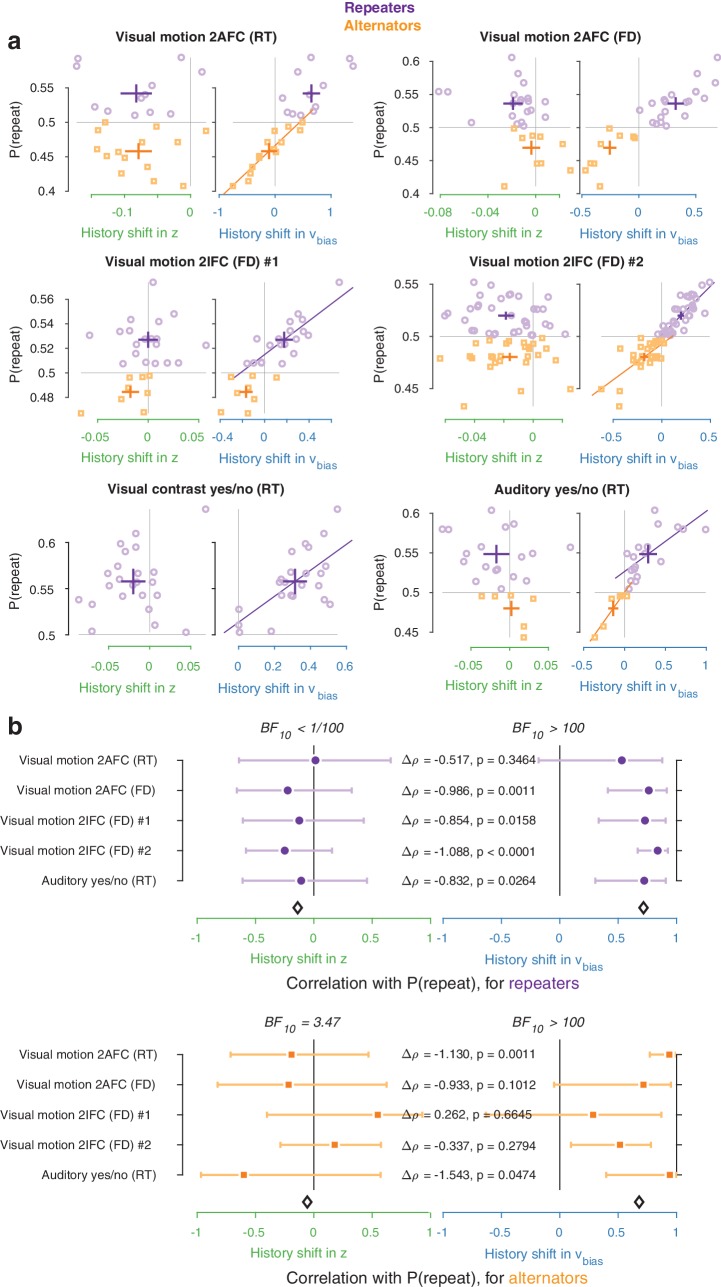
Same biasing mechanism under two pharmacological interventions.(a) Participants in the MEG study were assigned to one of three pharmacological groups. At the start of each experimental session, they orally took 40 mg atomoxetine (Strattera), 5 mg donepezil (Aricept), or placebo. Since the time of peak plasma concentration is 3 hr for donepezil (Rogers and Friedhoff, 1998) and 1–2 hr for atomoxetine (Sauer et al., 2005), we used a placebo-controlled, double-blind, double-dummy design, entailing an identical number of pills at the same times before every session for all participants. Participants in the donepezil group took 5 mg of donepezil 3 hr, and placebo 1.5 hr before starting the experimental session. Participants in the atomoxetine group took placebo 3 hr, and 40 mg of atomoxetine 1.5 hr before the experimental session. Those in the placebo group took identical-looking sugar capsules both 3 and 1.5 hr before starting the session. This ensured that either drug reached its peak plasma concentration at the start of the experimental training. The drug doses were based on previous studies with healthy participants (Chamberlain et al., 2009; Rokem and Silver, 2010). Blood pressure and heart rate were measured and registered before subjects took their first and second pill. In the 3 hr before any MEG or training session, participants waited in a quiet room. In total, 19 people in the placebo, 22 in the atomoxetine, and 20 in the donepezil group completed the full study. (b, c) Choice history biases separately for each pharmacological group. Since we did not observe differences in choice history bias between these groups, we pooled all observers for the main analyses.